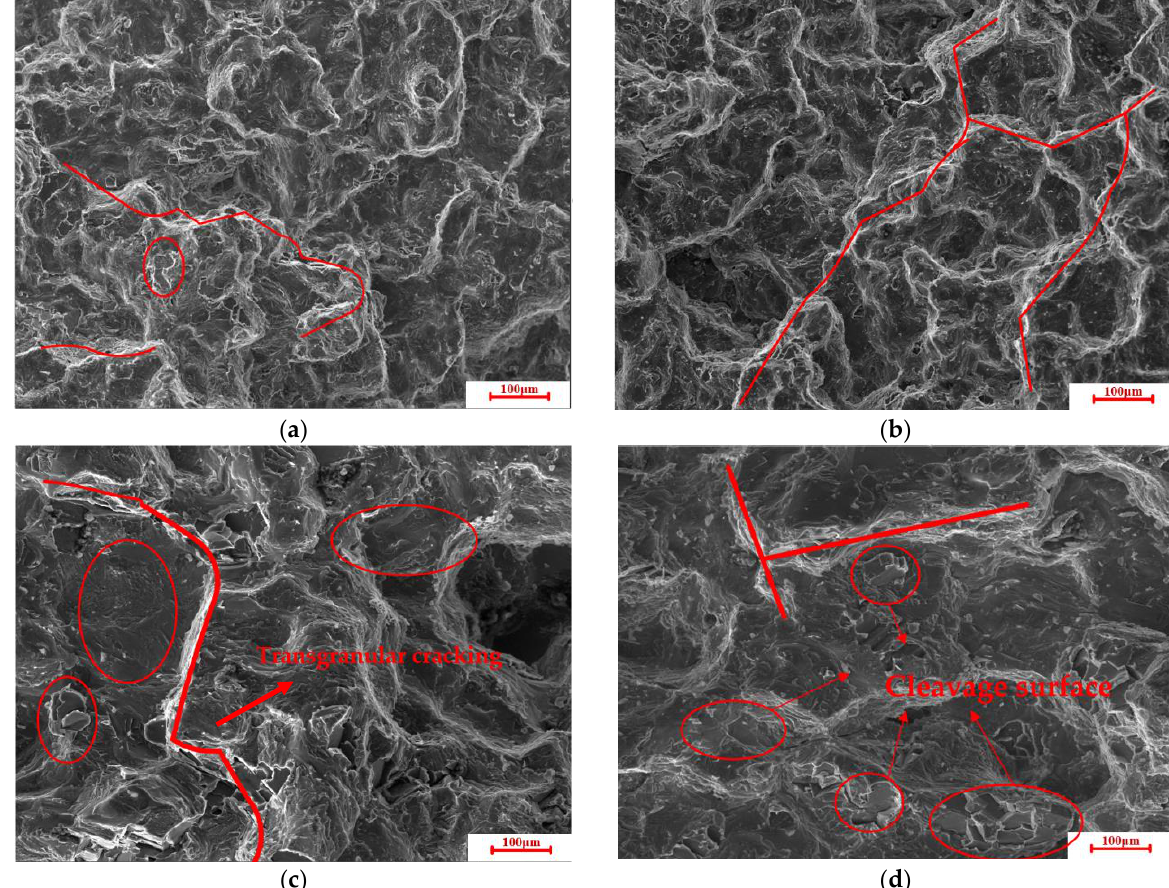
Figure 9. SEM image of the tensile fracture surface of the ingot using USMT: ( a ) axial part; ( b ) radial part; ( c ) axial part of the ingot without USMT; and ( d ) radial part without USMT.